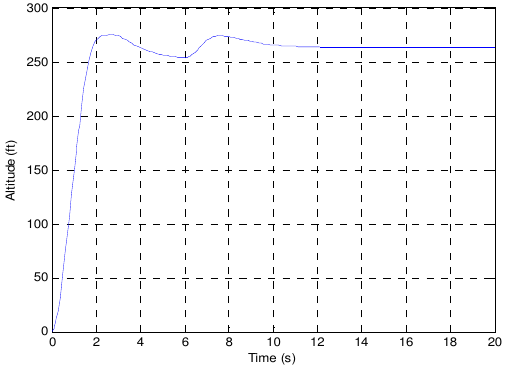
Fig . 14. The airspeed performance control for both .